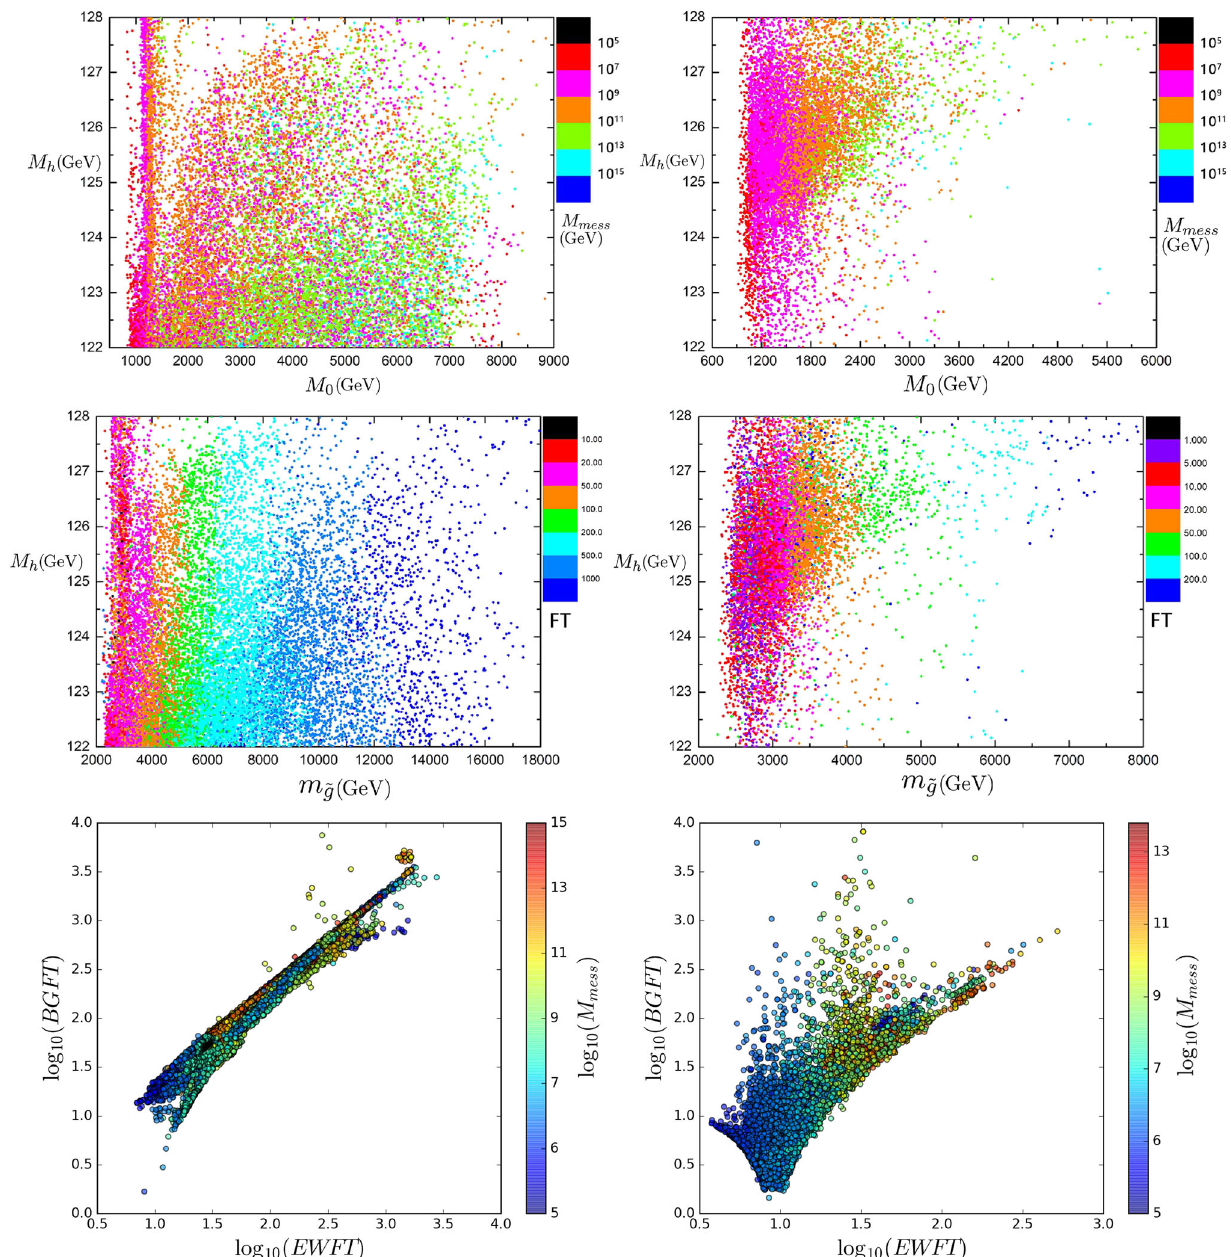
Fig. 2 Scatter plots of the SM-like Higgs mass m h versus the modulus mediation parameter M 0 and gluino mass m ˜ g for Type A (left panels) or Type B (right panels). The fine-tuning measures given in the middle of the panels ( m h vs m ˜ g ) are the Barbieri–Giudice fine tuning (BGFT)